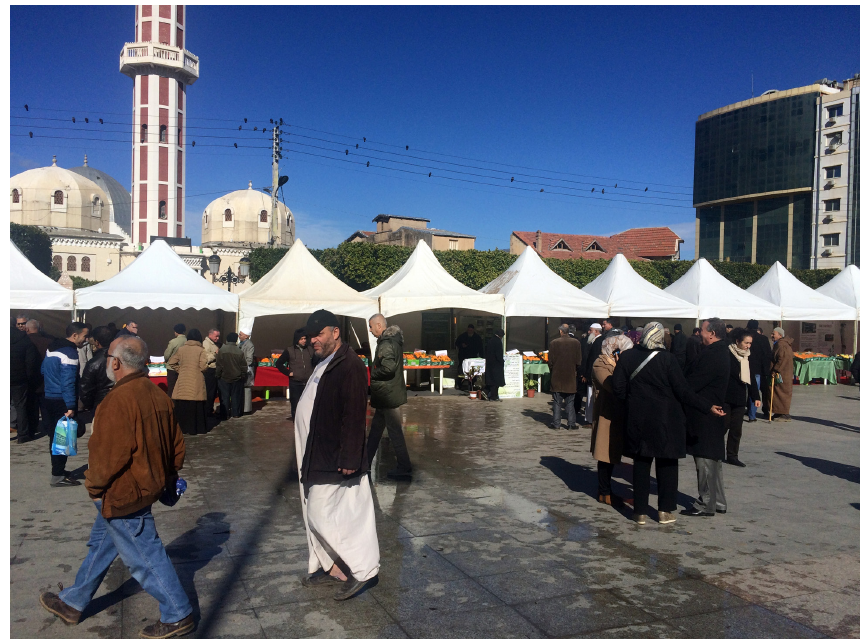
Fig. 3 Blida’s liberty Square, support for activities related to experiential